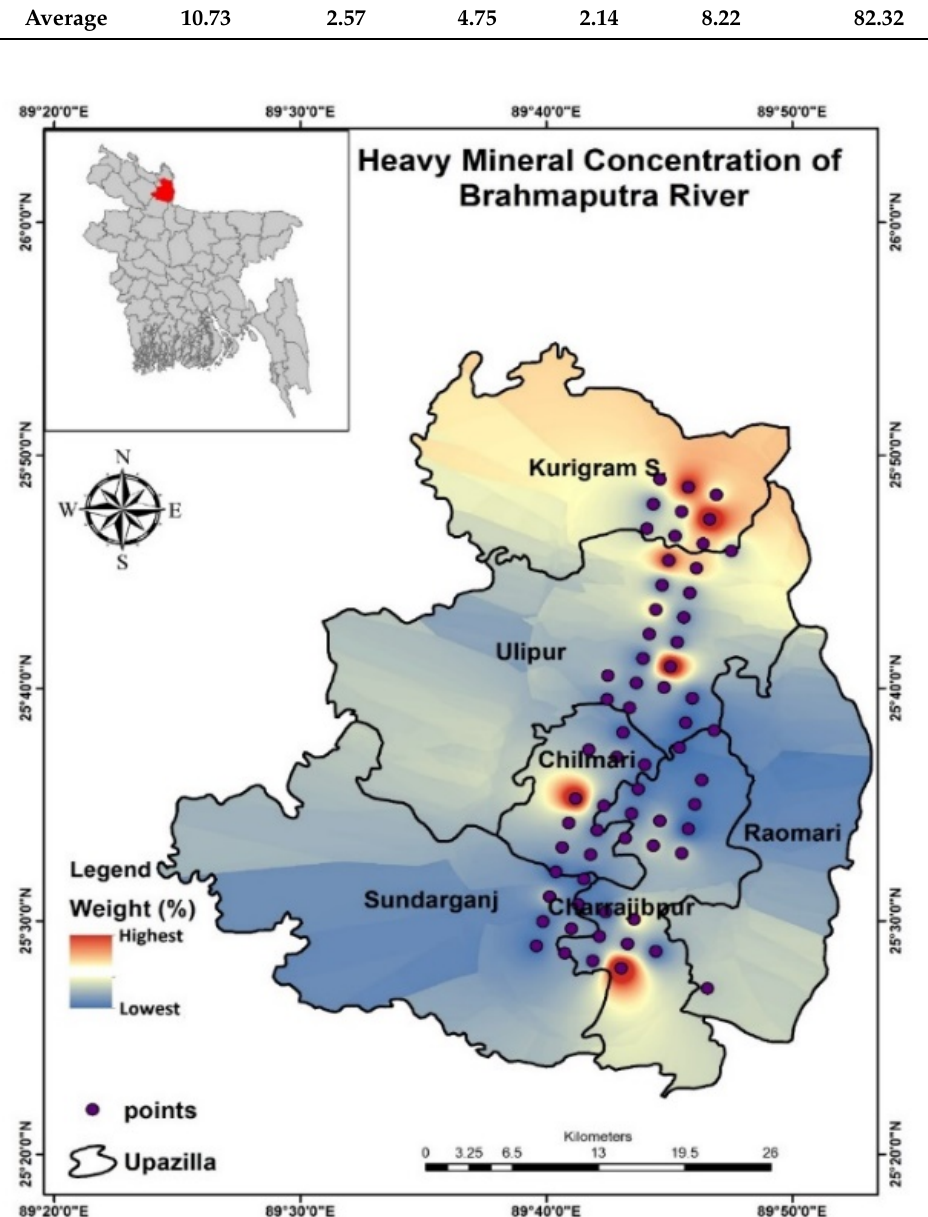
Figure 4. Map showing the concentration of VHM from each sample location. In general, VHM contents were highest in the upstream region. Table 2. The average THM concentration and abundance of VHM within the three stream divisions.